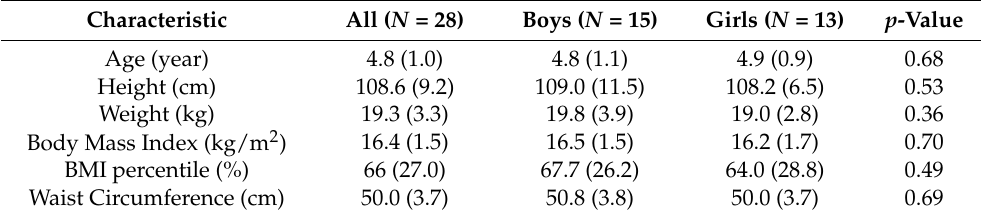
Table 2. Descriptive characteristics of the participants, mean (standard deviation) or percentile. Characteristic